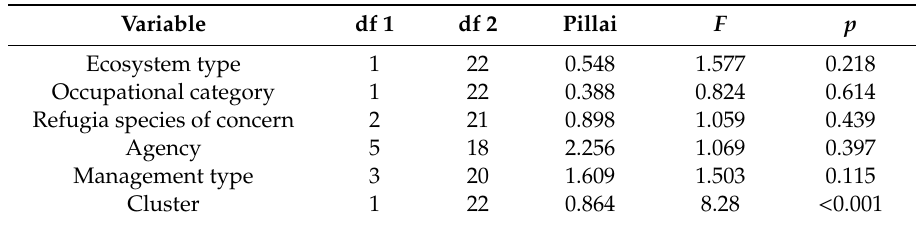
Table 1. Multivariate analysis of variance (MANOVA) test for di ff erences on response scores between demographic groups. df 1 and df 2 are the degrees of freedom, Pillai is the Pillai’s trace test statistic, F is the F -statistic, and p is the p -value.